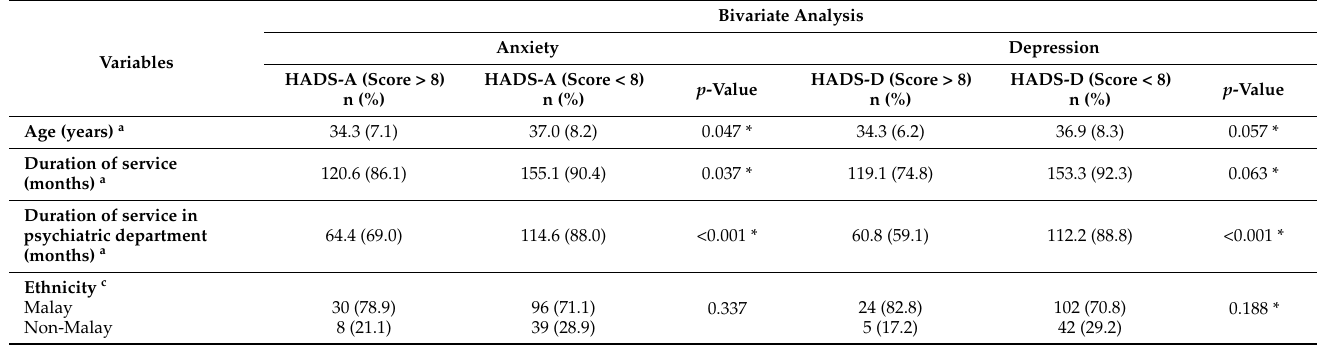
Table 3. Bivariate analysis for socio-demographic, socio-economic, work-related factors, and coping strategies associated with anxiety and depression among psychiatric healthcare workers at University Malaya Medical Centre (n =